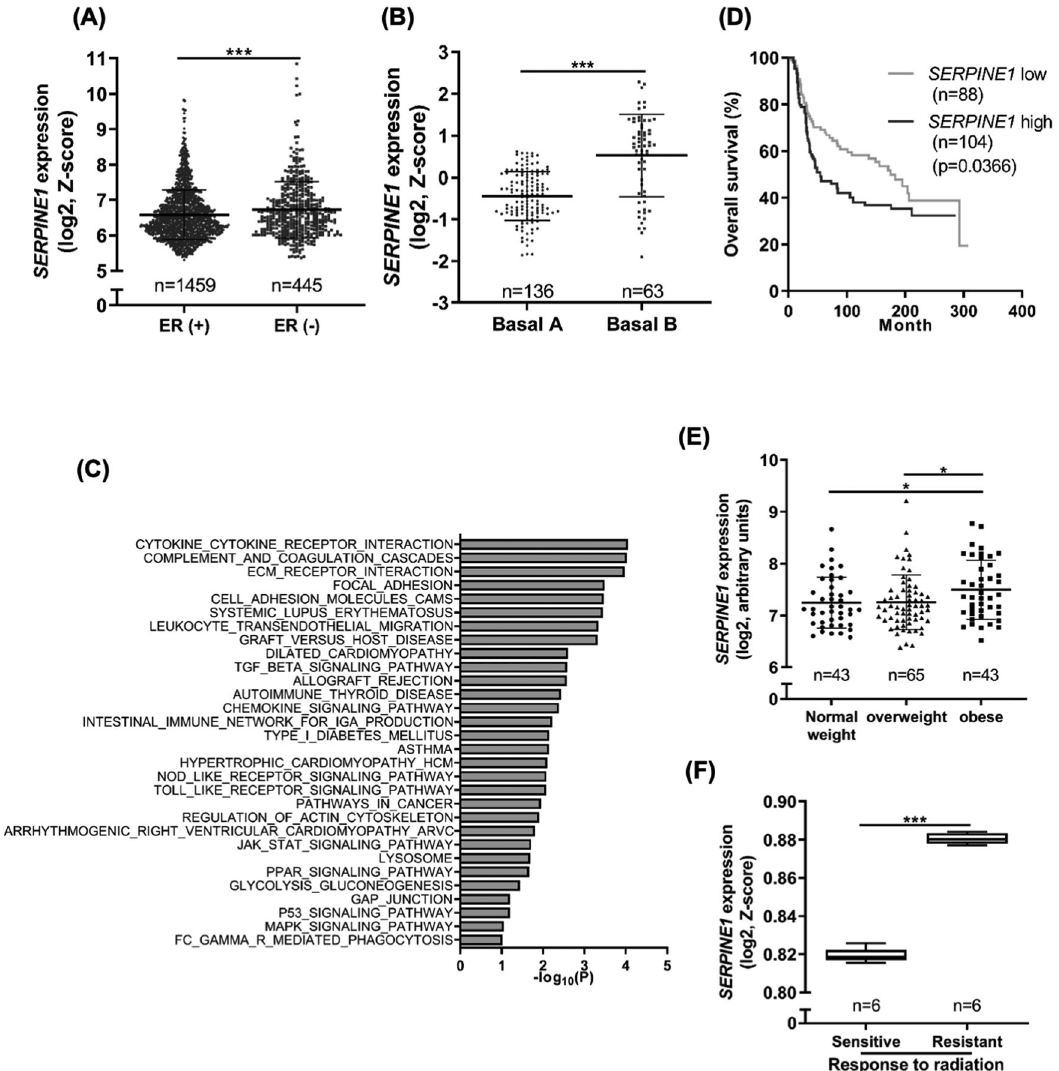
Fig. 6 SERPINE1 was positively correlated with worse clinical outcomes. A – D Analyses of RNA-sequencing data from METABRIC dataset. SERPINE1 expression in the breast tumors with different ER status ( A ) or TNBC subtypes ( B ). C Gene set enrichment analysis (GSEA) using KEGG database. Top 30 upregulated biological pathways among SERPINE1-high group were shown. D Overall survival rate of TNBC patients. E SERPINE1 expression level in breast tumor tissues of TNBC patients with different BMI status. Normal weight: BMI < 25; overweight: 25 <BMI < 30; obese: BMI > 30 (GSE76124). F SERPINE1 expression in parental or radioresistant MDA-MB-231 cell lines